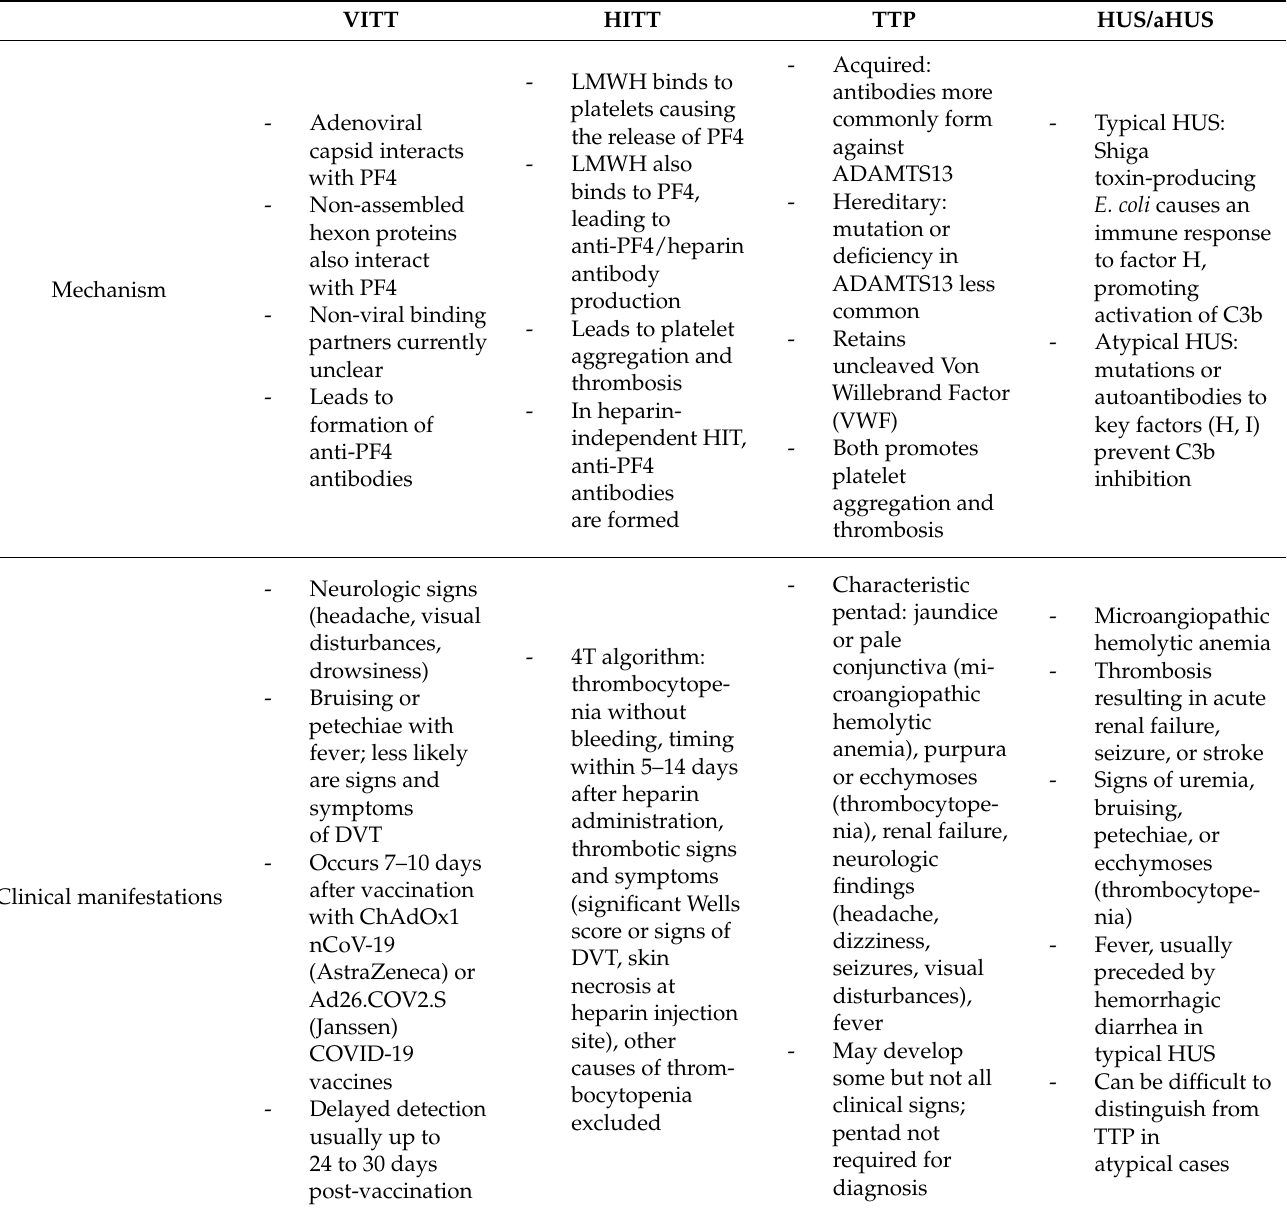
Table 2. Clinical features, diagnosis, and treatment of thrombotic thrombocytopenic